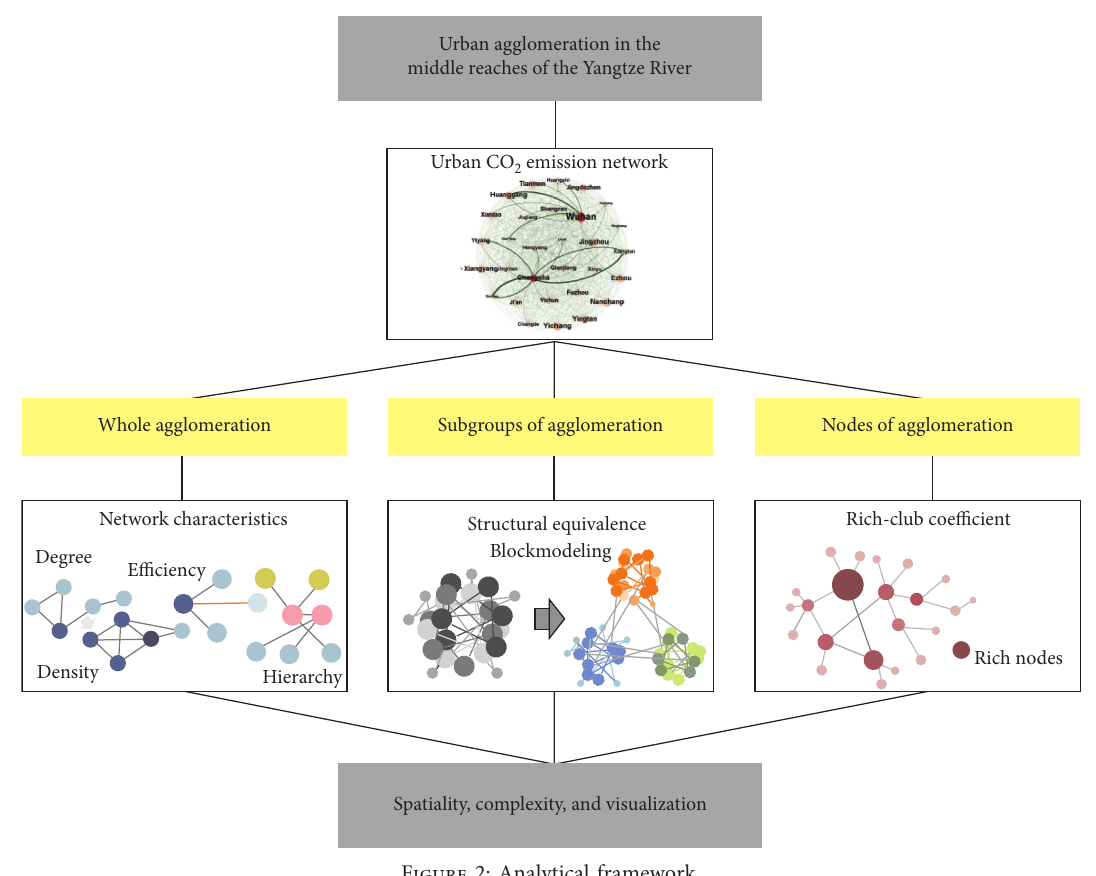
Figure 2: Analytical